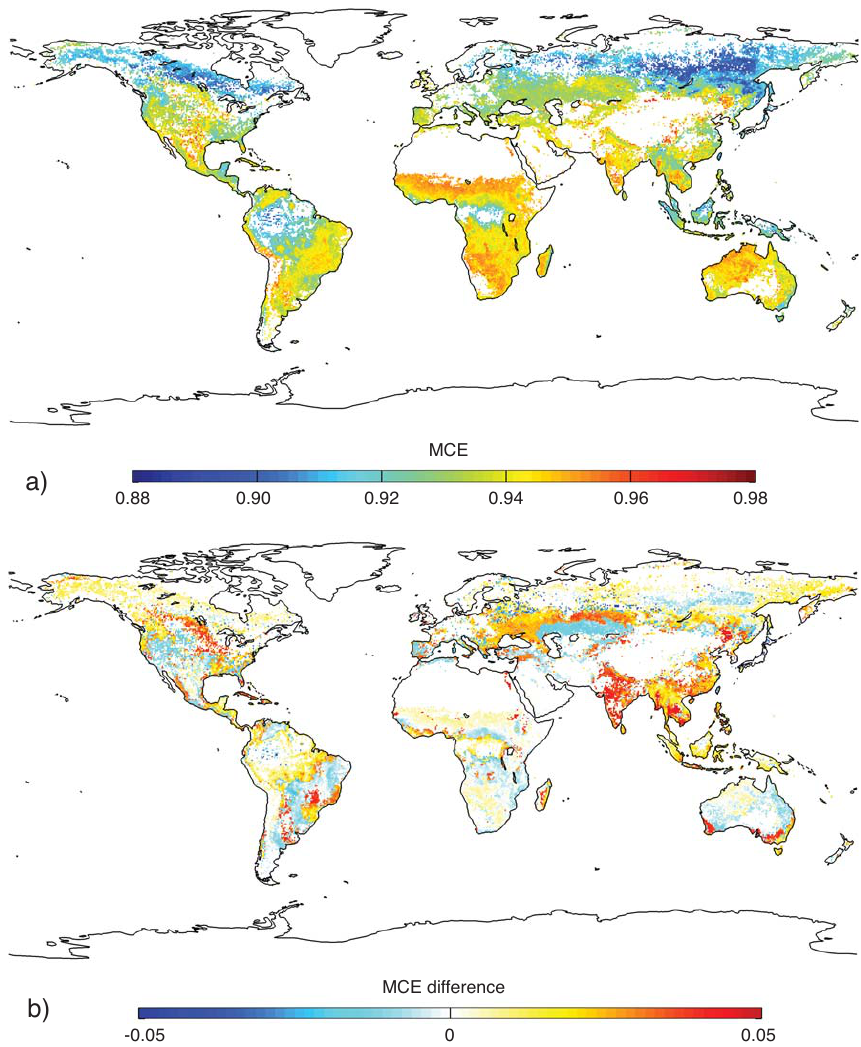
Fig. 6. (a) MCE based on a multivariate regression equation that combined different environmental variables (see Sect. 3.6), with a spatial resolution of 0.5 ◦ × 0.5 ◦ and weighted by the monthly amount of biomass combusted according to GFED3.1 for the years 1997–2008. (b) Difference between (a) and the biome average MCE according to data of A&M2001–2009. Fires in peatlands which have a very low MCE were neglected